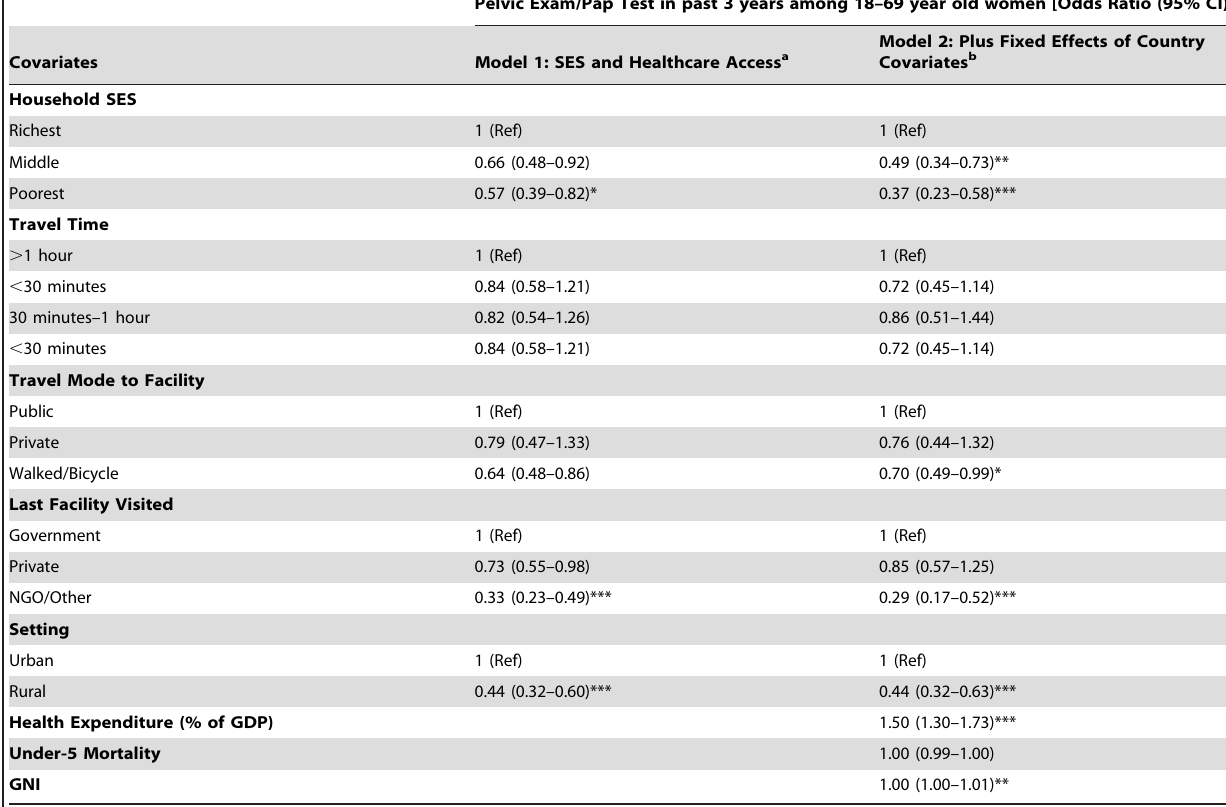
Table 2. Socio-Demographic Economic and Healthcare Access Determinants of Cervical Cancer Screening.